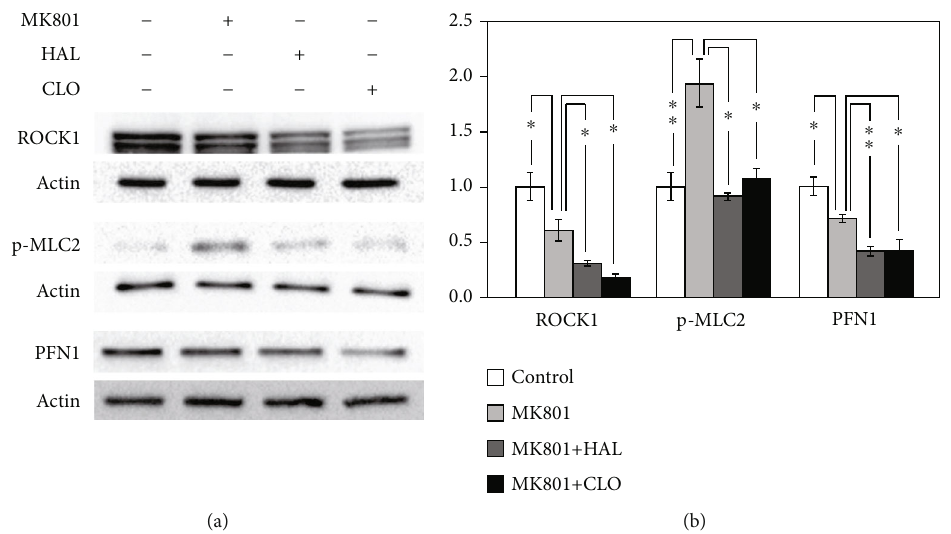
Figure 3: E ff ects of MK801, haloperidol (HAL), and clozapine (CLO) on ROCK1, p-MLC2, and PFN1 regulation in B35 cells. (a) Western blot revealing APD-induced changes in the expression of ROCK1, p-MLC2, and PFN1 proteins in B35 cells. (b) Protein expression was quanti fi ed and normalized to beta-actin, and the relative expression of each protein in the bar chart was calculated from triplicate western blot data obtained from three di ff erent batches of APD-treated cells and analyzed using ANOVA followed by Dunnett ’ s test ( ∗ p value < 0.05; ∗∗ p value < 0.01).